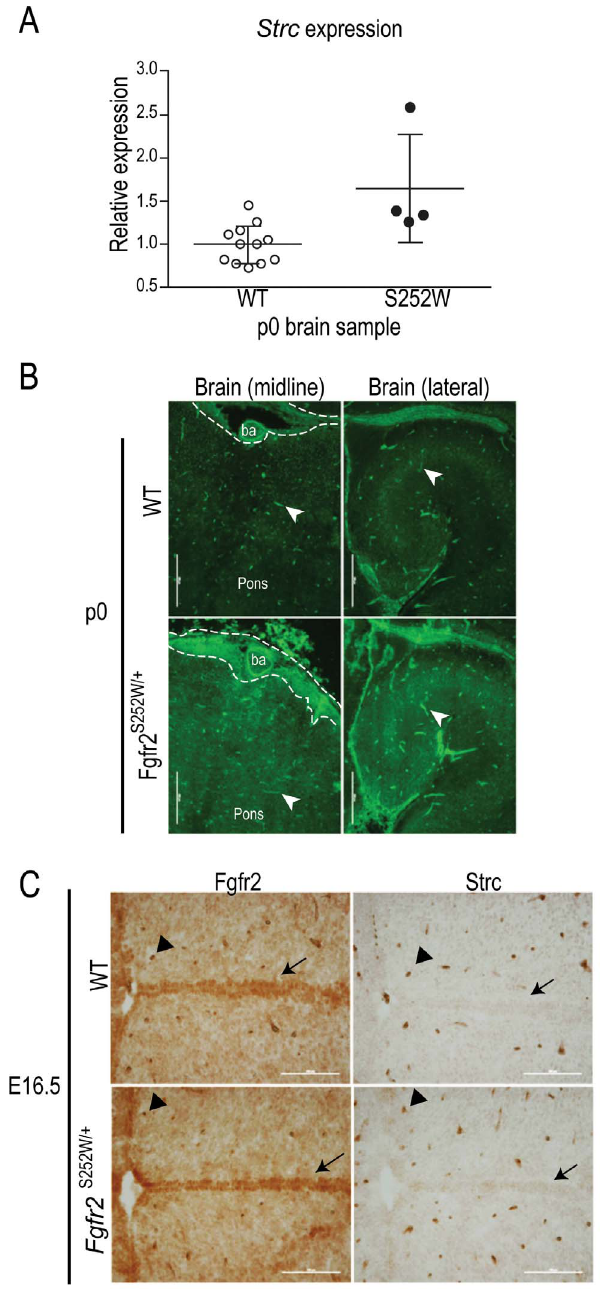
Figure 2. S252W mouse experiments. (A) Quantitative RT-PCR results for CNS related DEG, Strc , in p0 Fgfr2 + / + (WT) and Fgfr2 + /S252W littermates whole brain RNA. (B) Strc immunostaining in the midline and lateral sections of WT and Apert P0 brains. White arrow points to blood vessel cells expressing Strc and dashed lines delimit high Strc expression area in the ventral portion of the pons. ba: basilar artery. (C)Anti-Fgfr2 and the Strc antibody on adjacent frozen sections of E16.5 WT and Apert brains visualized with DAB. Areas of neural tissue expressing Fgfr2 but not Strc are indicated by black arrows. Blood vessels double positive for Fgfr2 and Strc are indicated by arrowheads.